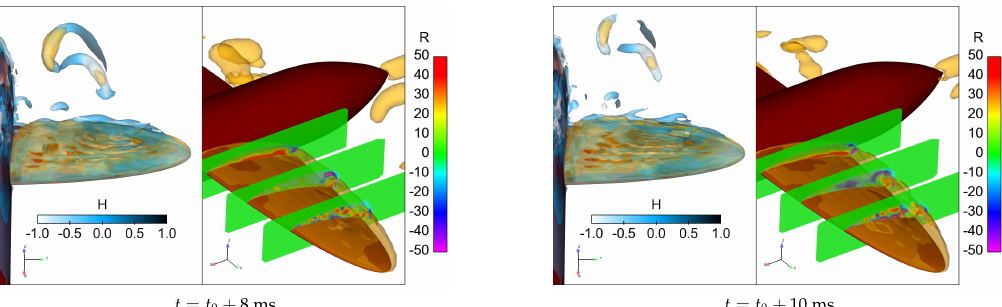
Figure 18. A sequence of snapshots depicting the formation of a partial cavitating ring vortex in the wake of the foil. DDES with medium grid, σ = 0.53. On the left in each frame: left foil with iso-surface of void fraction α = 0.1 colored as orange, together with an iso-surface of Q = 40,000, which is colored by the helicity H. On the right in each frame: three cut planes at y / s = [ 0.25,0.50,0.75 ] which are colored by the rate of evaporation R, with iso-surface of void fraction α = 0.1 colored as orange.